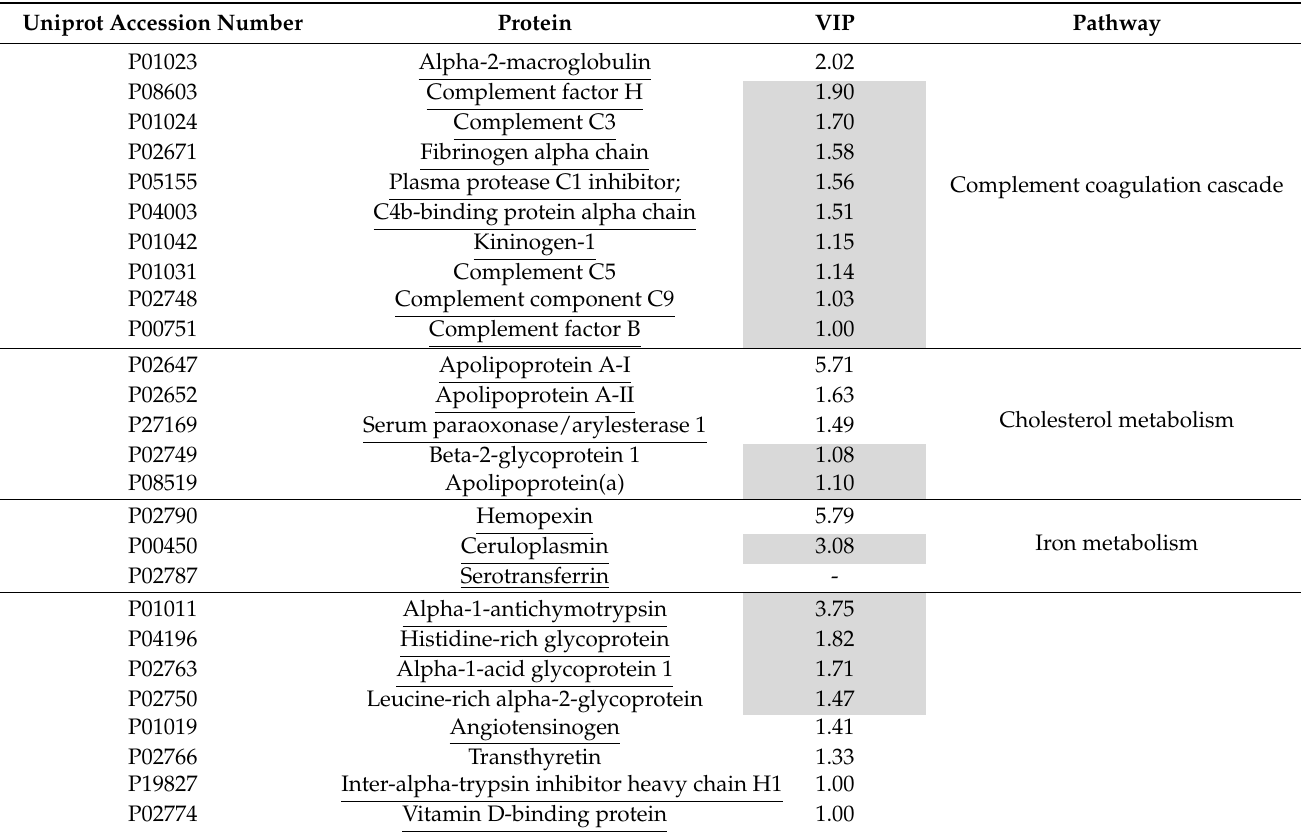
Table 1. Proteins important for the discrimination between controls and TB patients in multi- and univariate